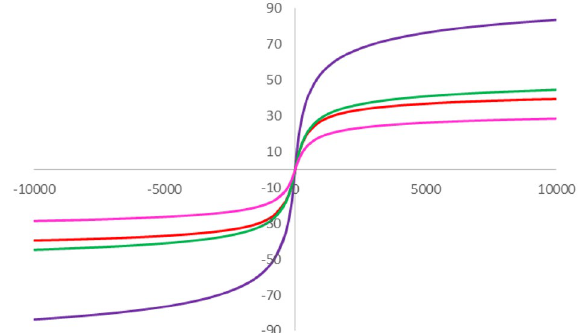
Figure 7. The VSM analyses of A , B , C and D .